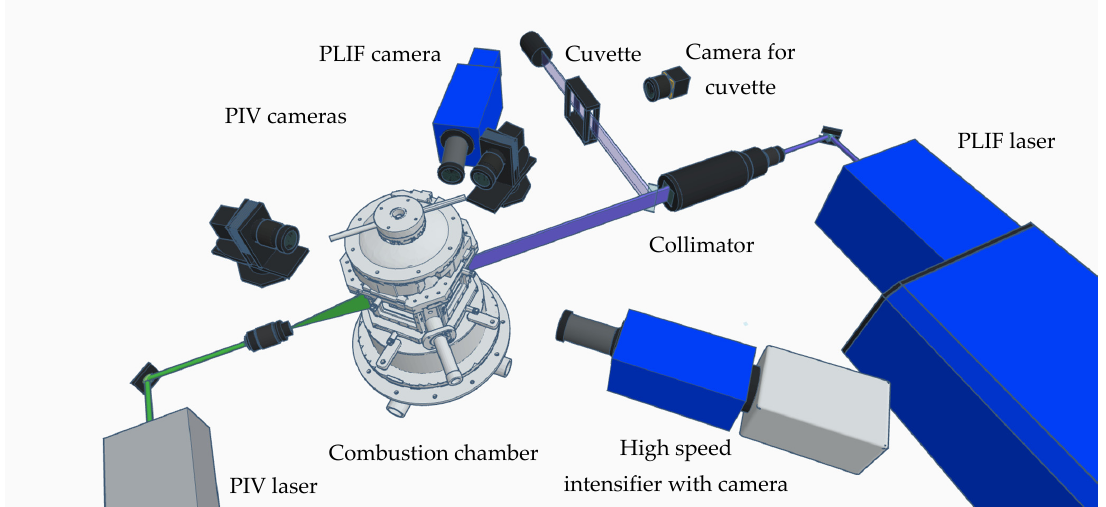
Figure 1. The scheme of the experimental setup.